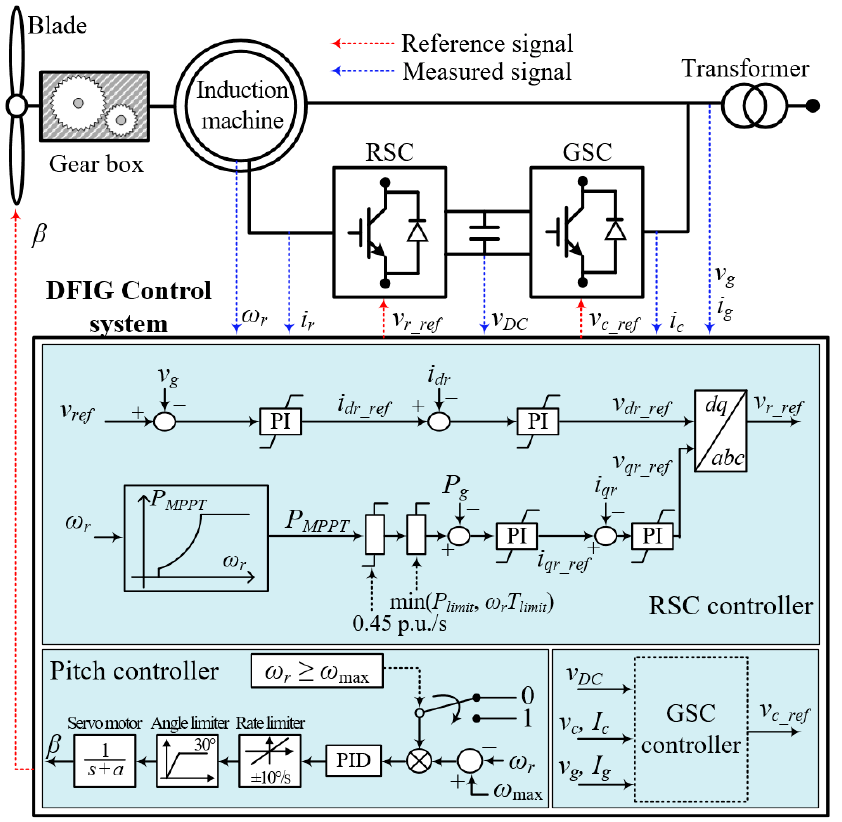
Figure 1. Simplified configuration of a DFIG model.